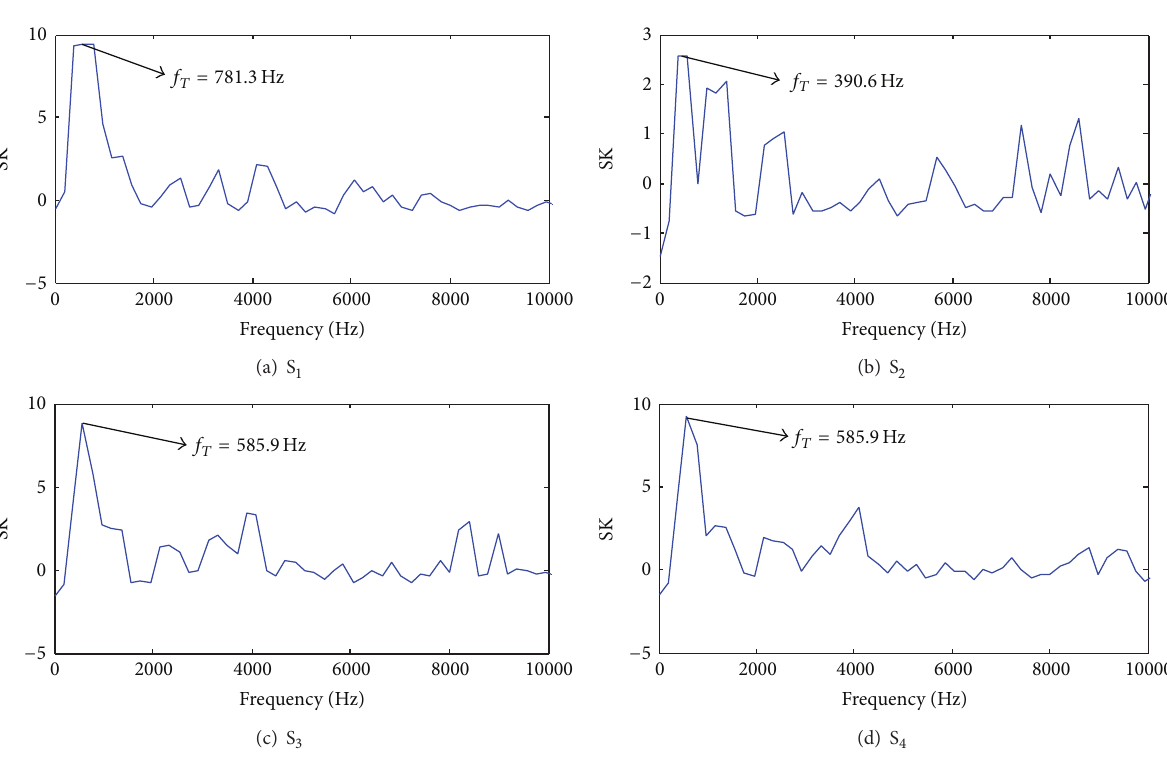
Figure 7: Corresponding 𝑓 𝑇 of